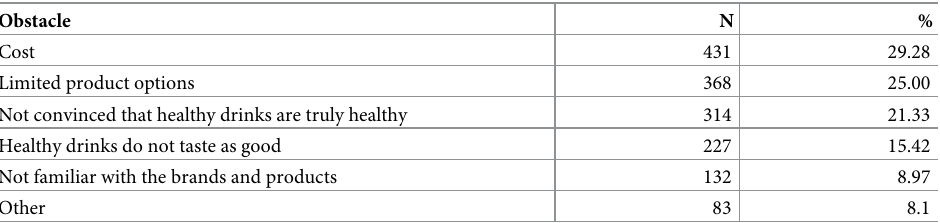
Table 7. Barriers to purchasing healthy beverages.